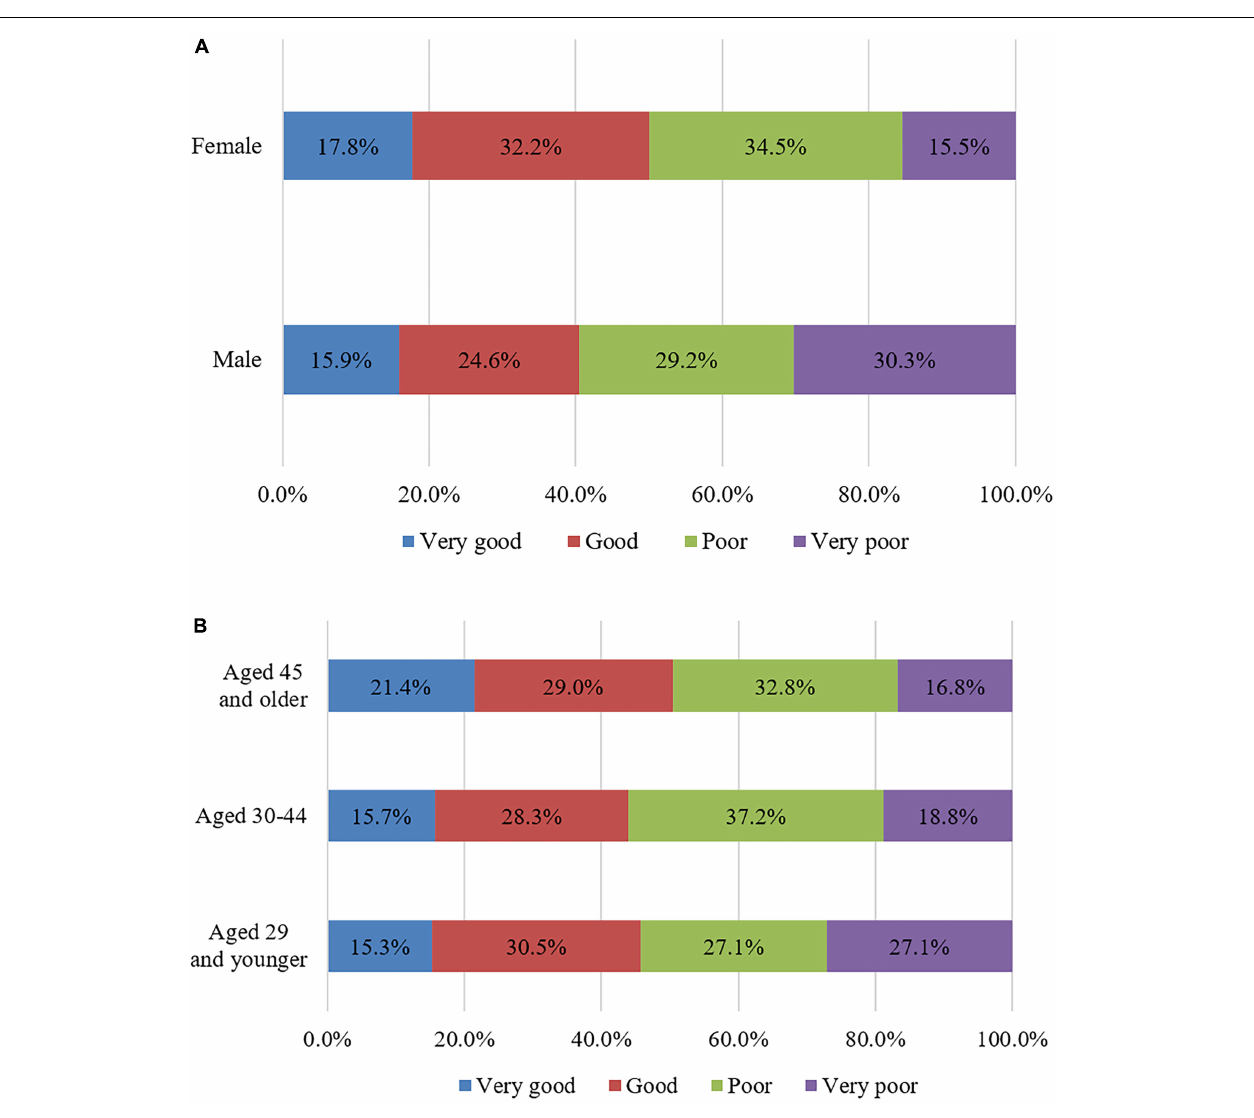
FIGURE 3 | The proportions of respondents’ various mental health states by gender and age. (A) Gender; (B)